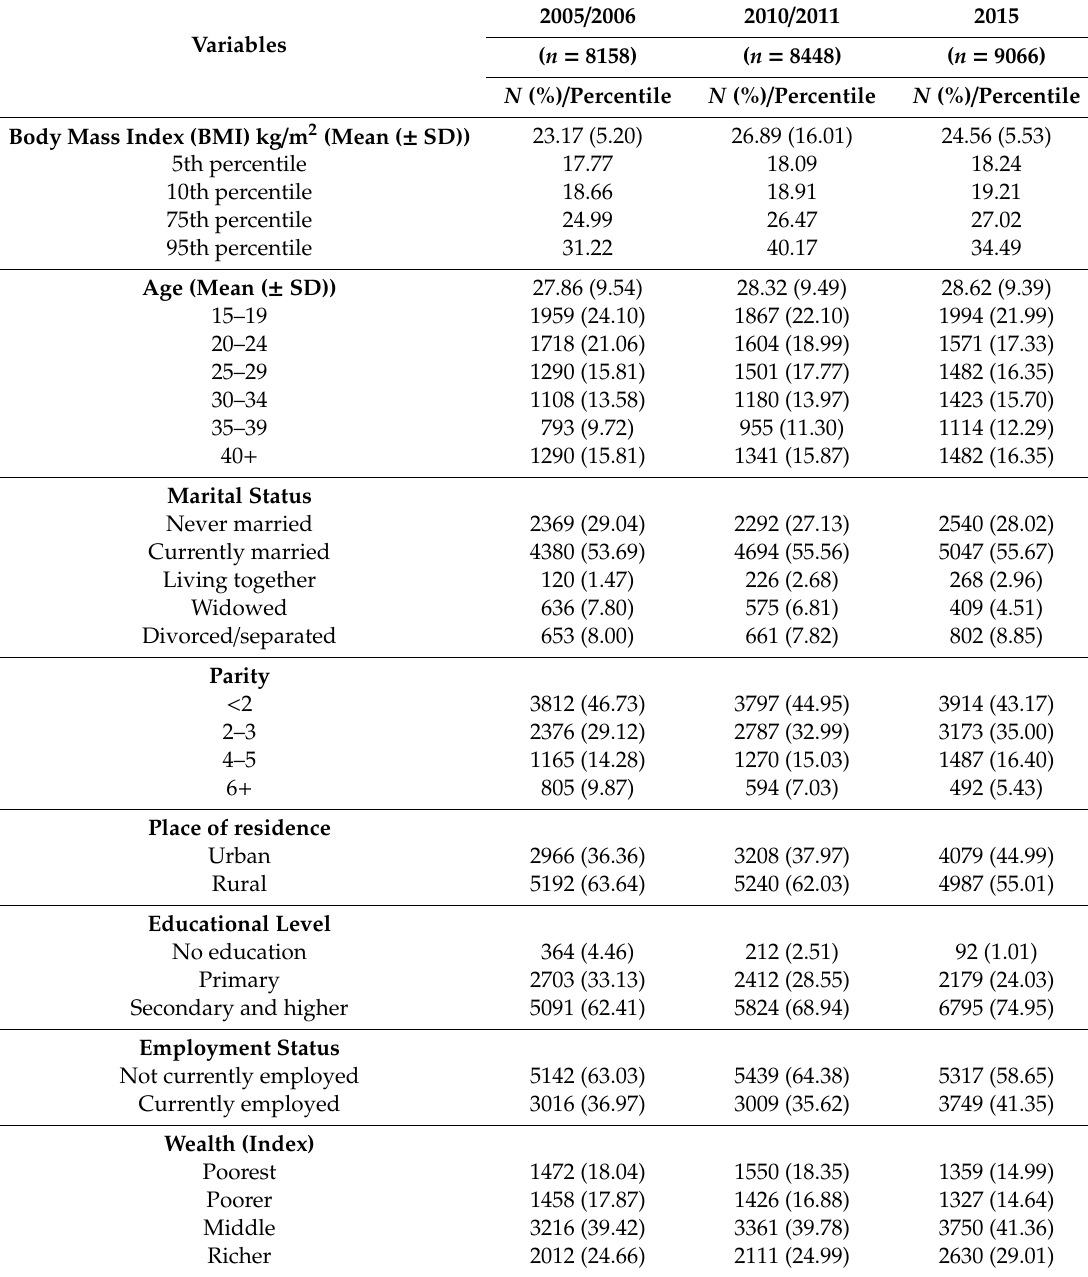
Table 1. Percentage distribution of the characteristics of women in Zimbabwe,